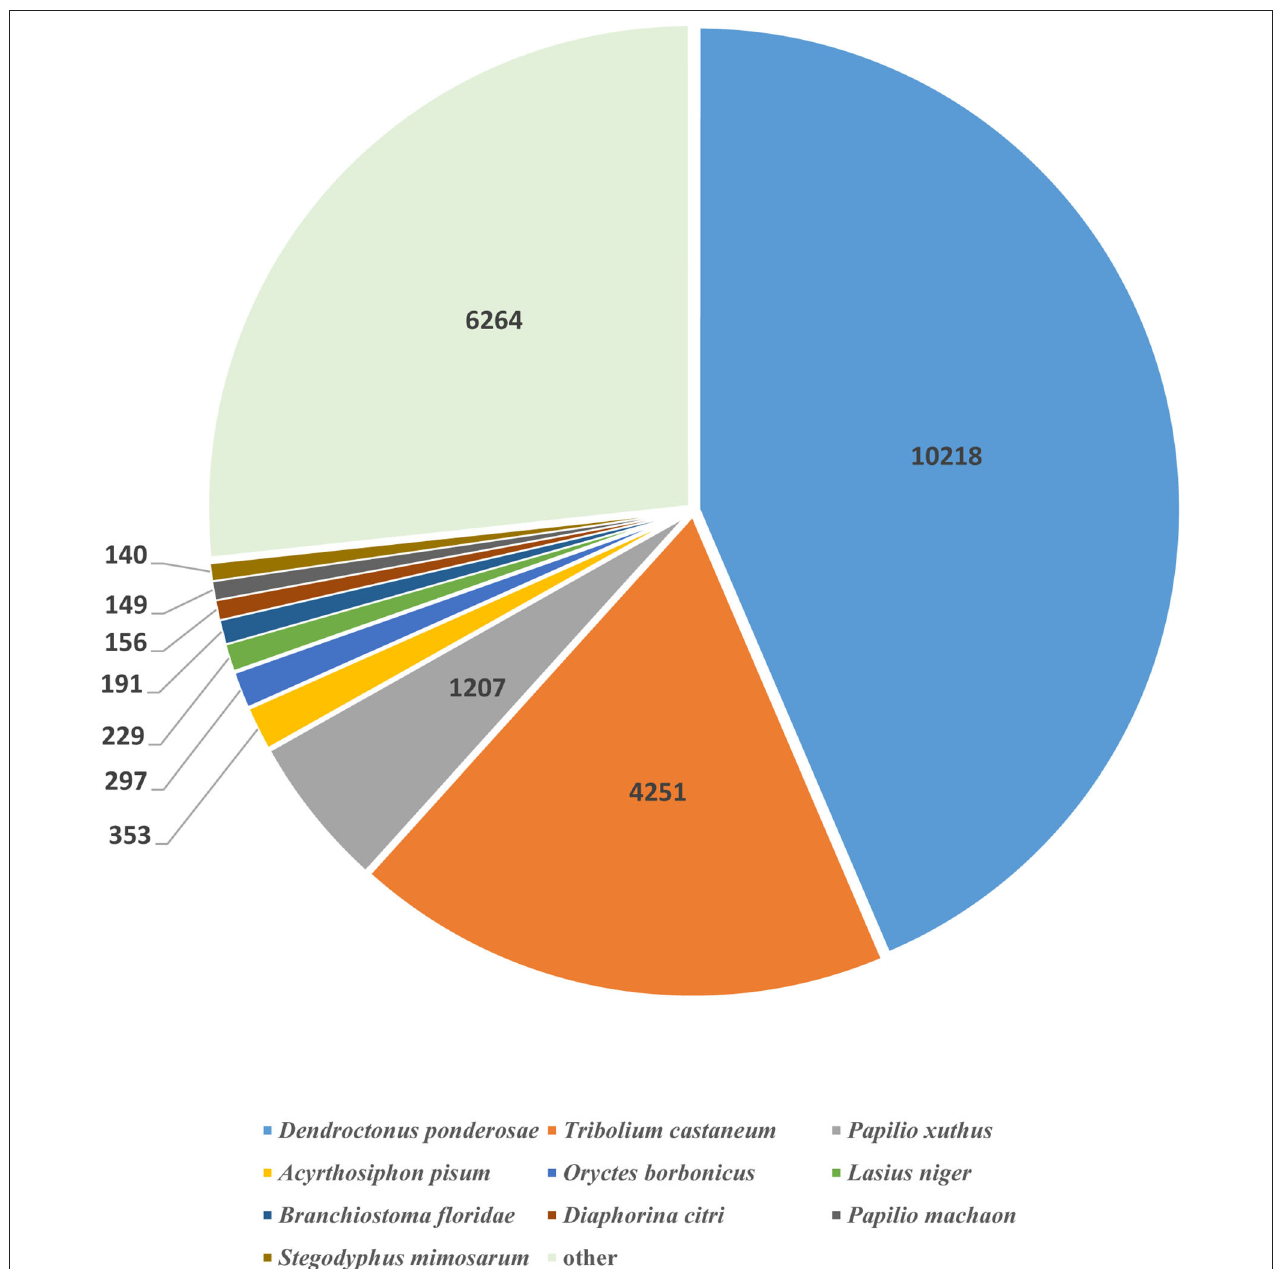
FIGURE 3 | Species distribution of top BLASTx results. The pie chart shows the species distribution of unigenes top BLASTx results against the NR protein database with a cutoff E value < 1e − 3 .